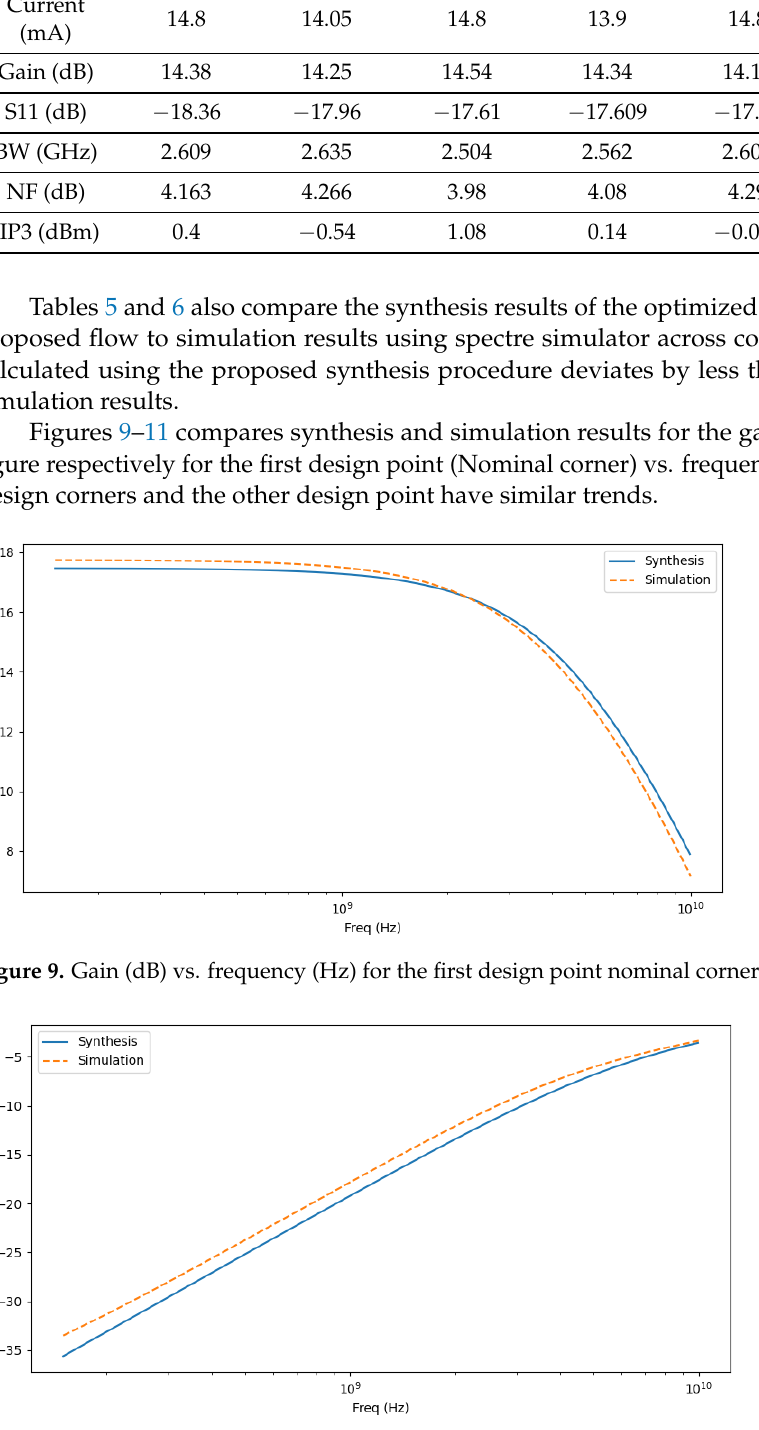
Figure 10. S11 (dB) vs. frequency (Hz) for the first design point nominal